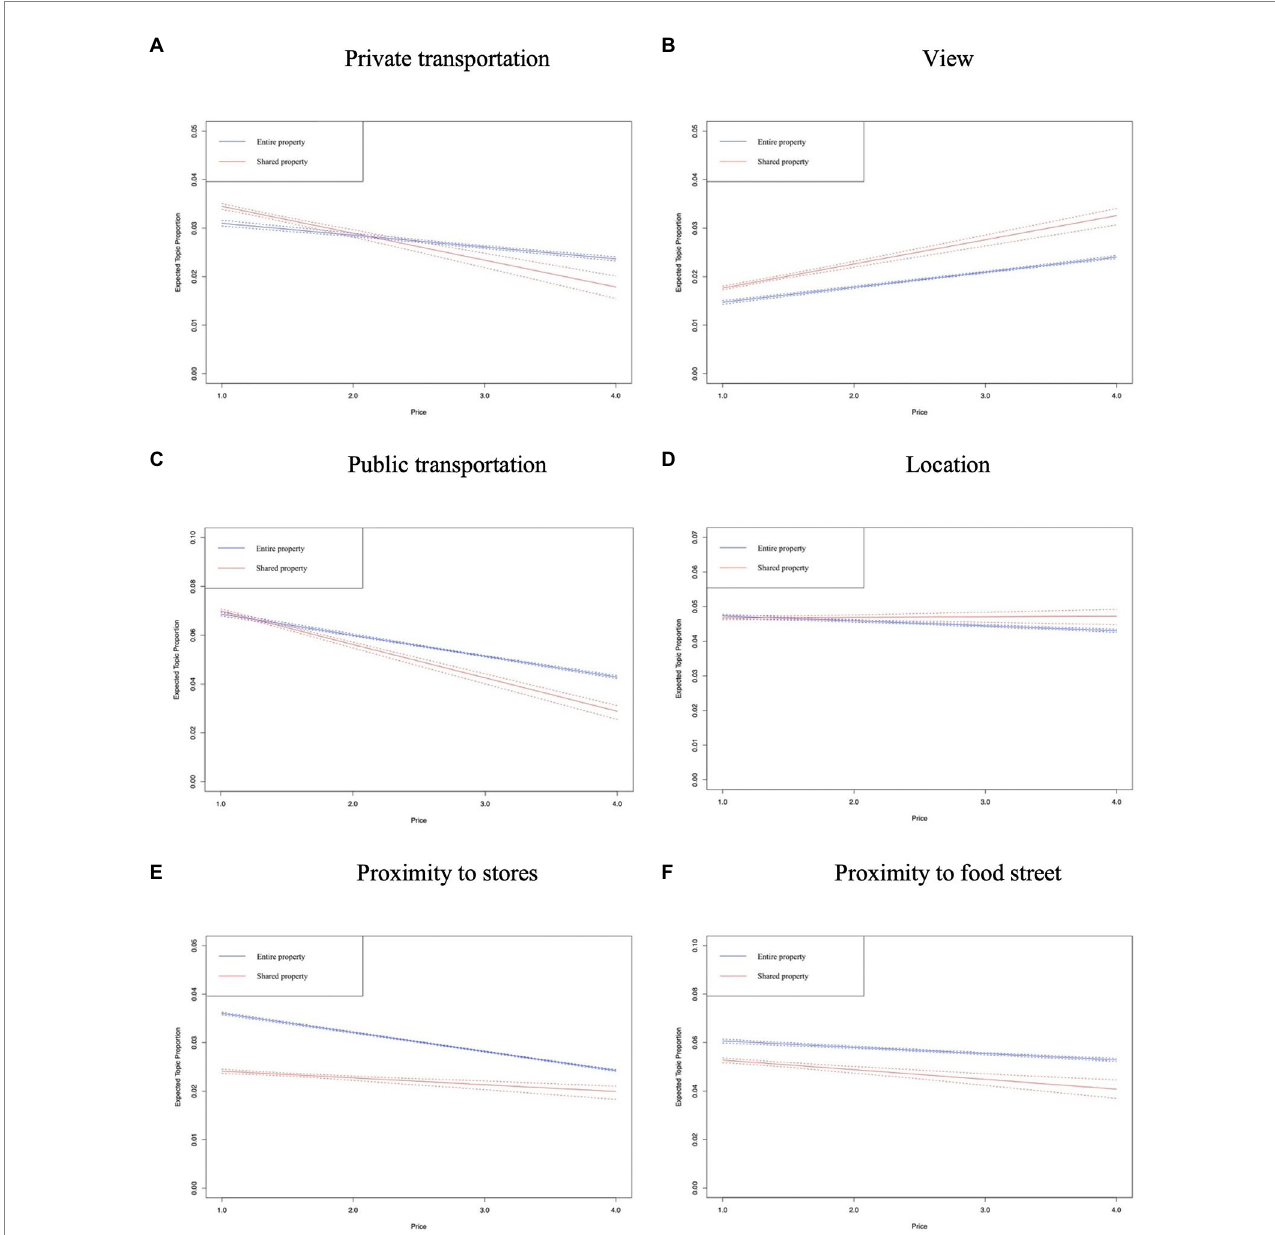
FIGURE 10 Topics in the dimension of location. (A) Private transportation. (B) View. (C) Public transportation. (D) Location. (E) Proximity to stores. (F) Proximity to food